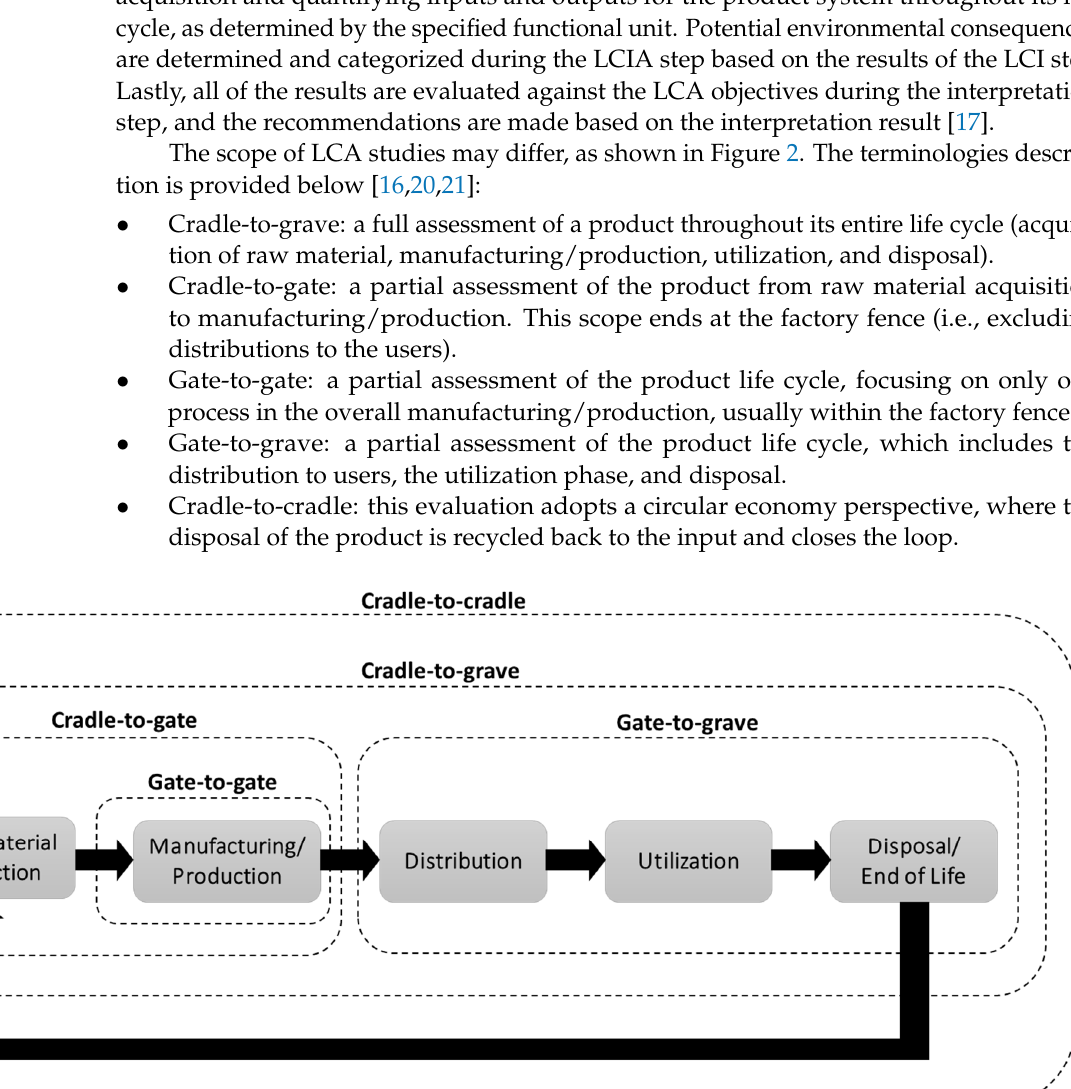
Table 1. LCA databases [18]. LCA Database